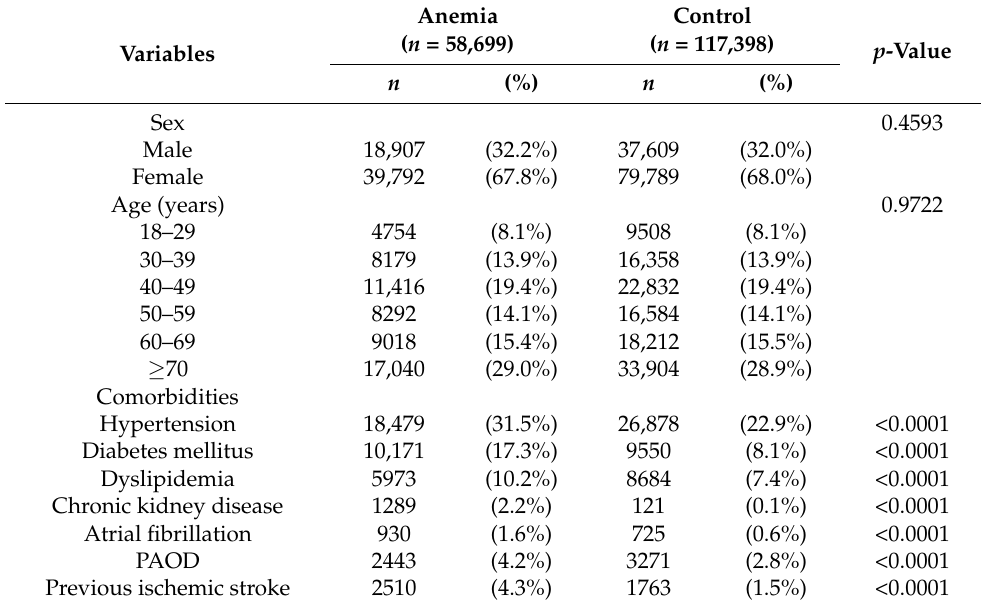
Table 1. Demographic characteristics of subjects with anemia and without anemia extracted from sample cohort.